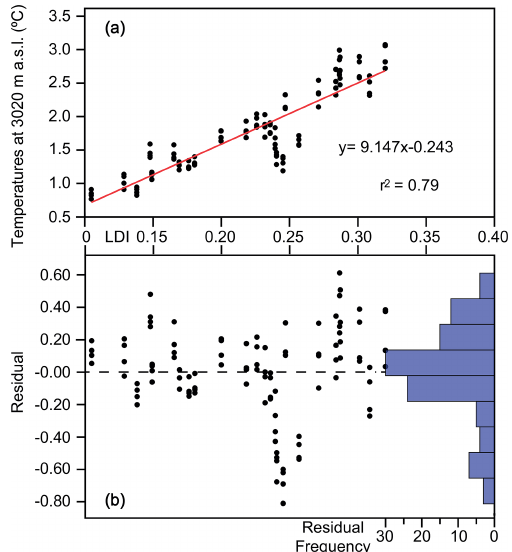
Figure 4. LDI temperature calibration. (a) Correlation by means of ordinary least square regression between both LDI records from LdRS (from 1908 to 2008) and the four reference temperature time series at 3020ma.s.l. (b) LDI values of LdRS vs. residual temper- atures (calculated between the calibrated LDI temperatures vs. ref- erence temperature time series at 3020ma.s.l.), as well as the his- togram of the frequency of these